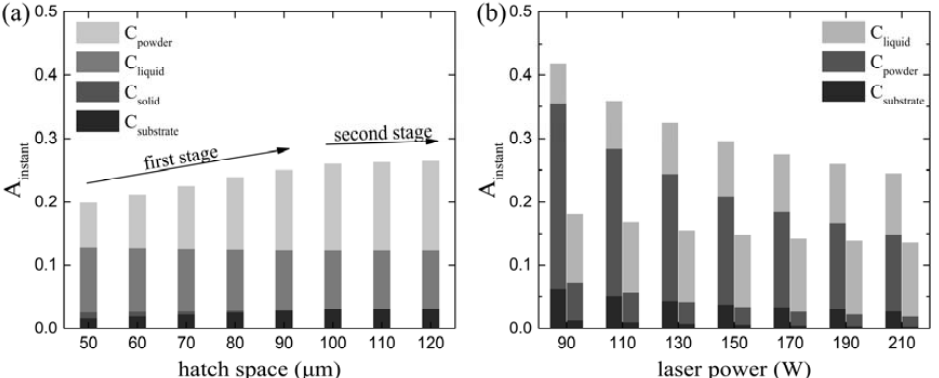
Figure 9. ( a ) A instant in the stable state versus hatch space at the parameter set II. ( b ) The A instant in the stable state versus laser power at the parameter set III, where the left column is at scanning velocity 1.25 m/s, and the right is at 0.25 m/s.